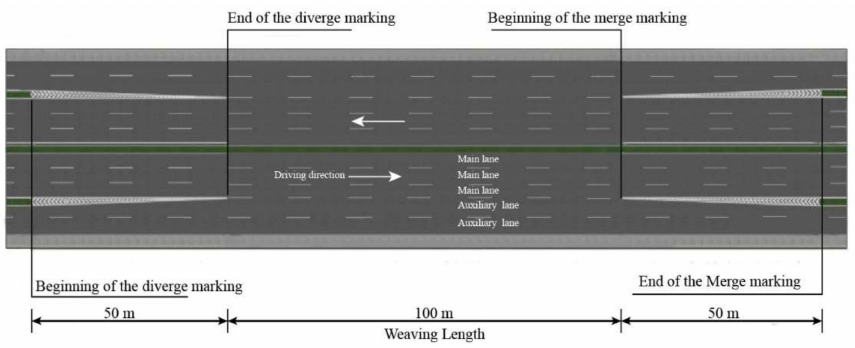
Figure 4. Schematic diagram of the weaving